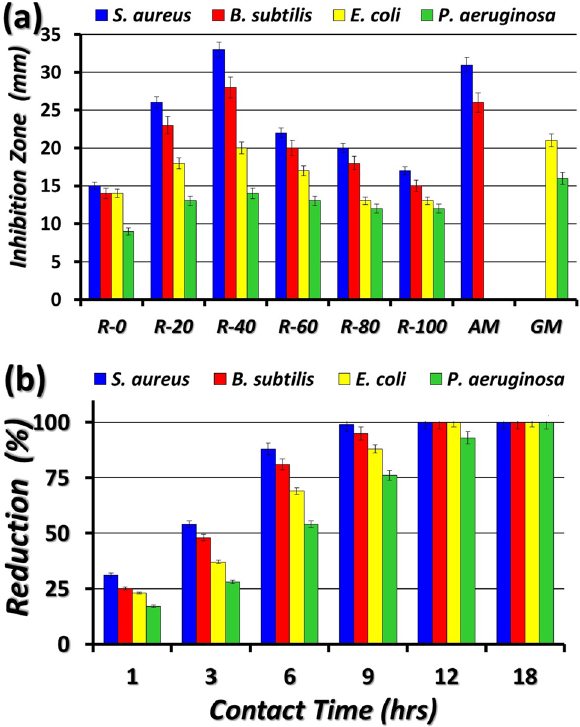
Figure 8. ( a ) Inhibition zones of blank and irradiated rosin and antibiotics (AM = Ampicillin and GM = Gentamicin) against four tested bacterial species, and ( b ) The reduction (%) of total viable bacterial counts (VBCs) for four tested bacterial species after exposure to irradiated rosin (R-40) at different contact times.